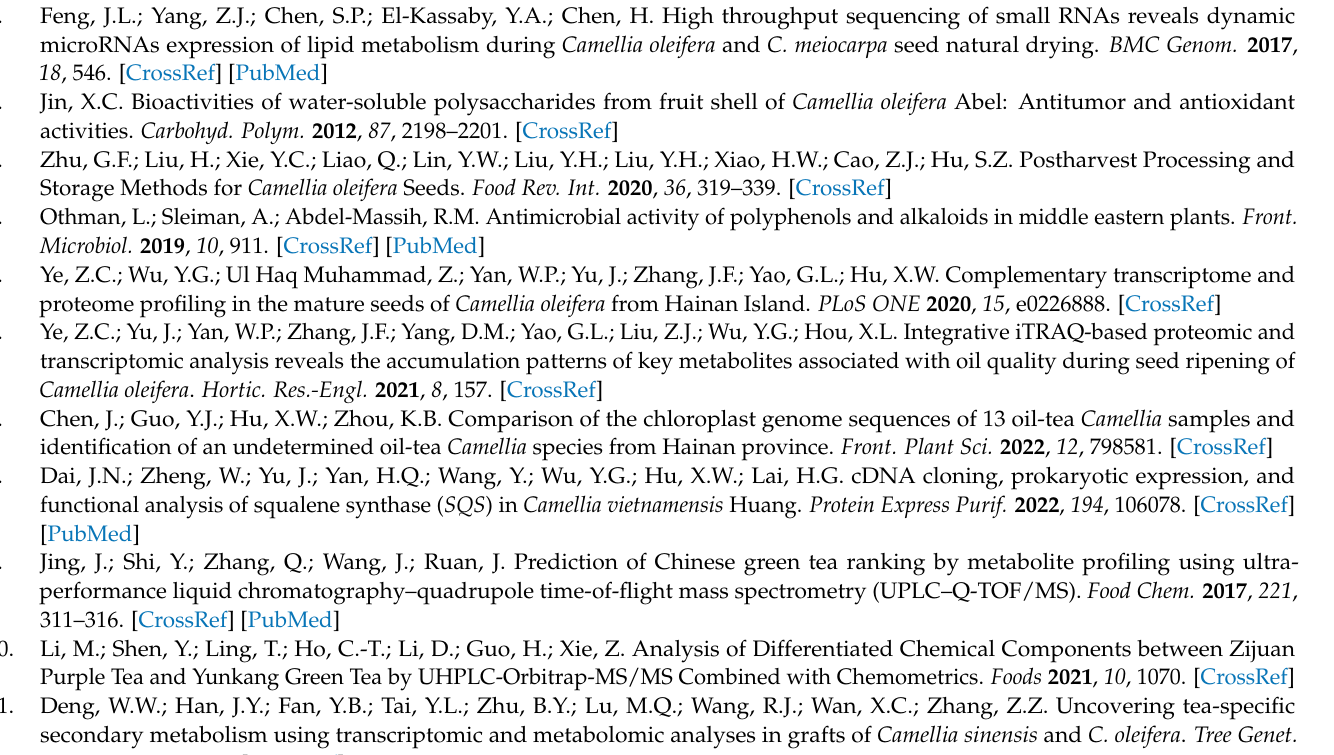
QTOFMS; Table S2: Metabolites in clusters; Table S3: Differentially Expressed Metabolites; Table S4: Regulatory network information of differentally expressed metabolites in seeds from C. vietnamensis at different maturity